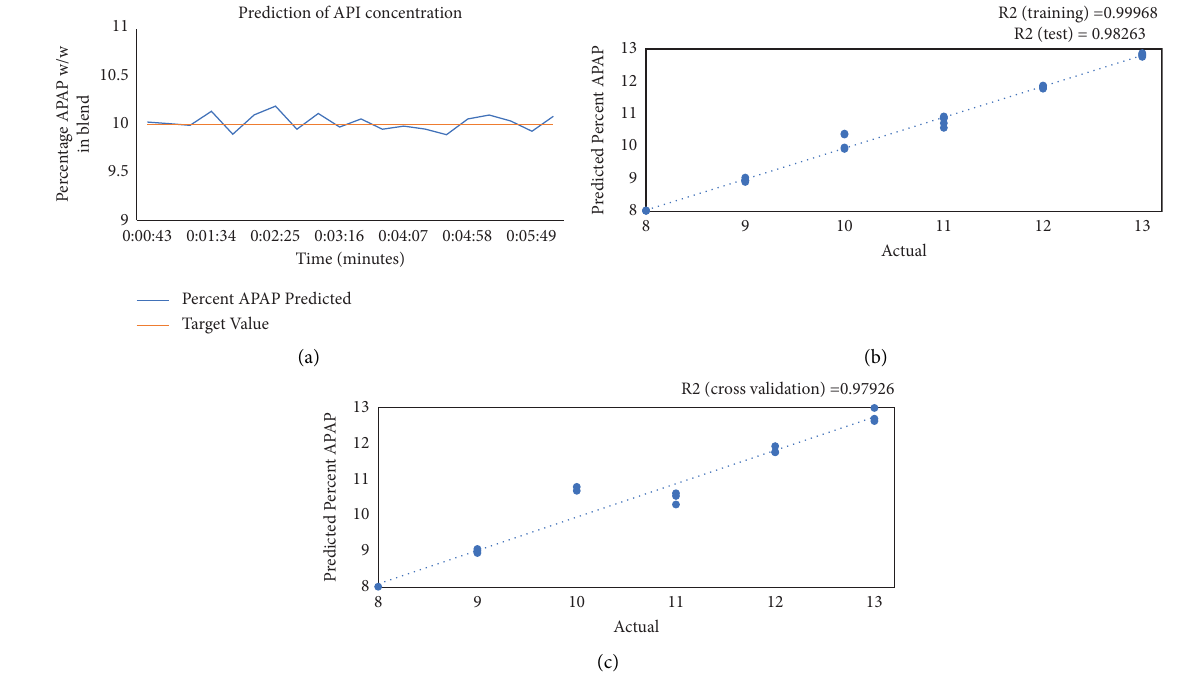
Figure 8: (a) Model predicted vs. Actual APAP concentration at feed frame of tablet press, (b) predicted vs. actual training for APAP in lactose, and (c) predicted vs. actual cross -validation for APAP in lactose.